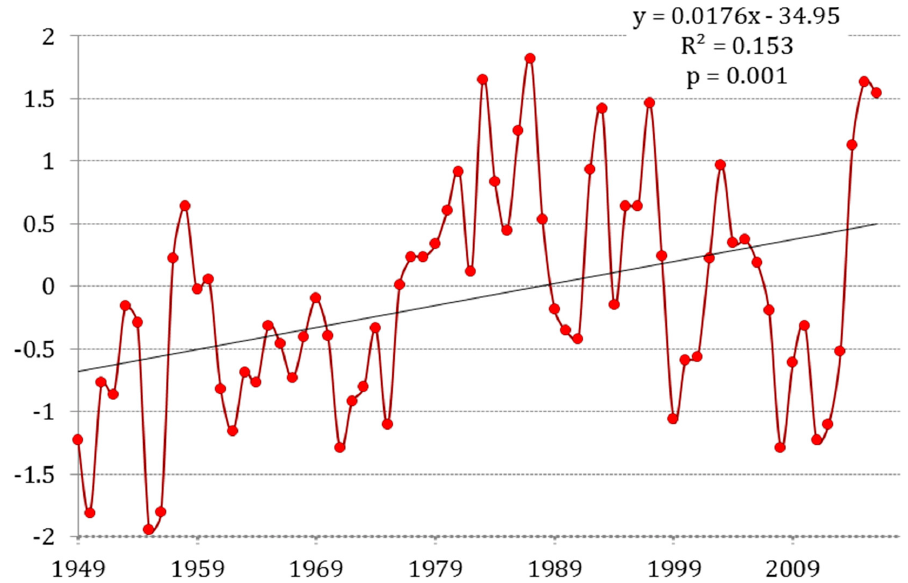
Figure 7. Time series of the mean annual PDO indices for 1949–2016.